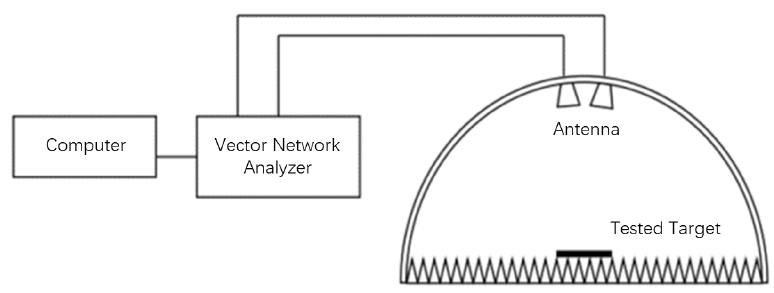
Figure 16. The diagram of the arched test system.